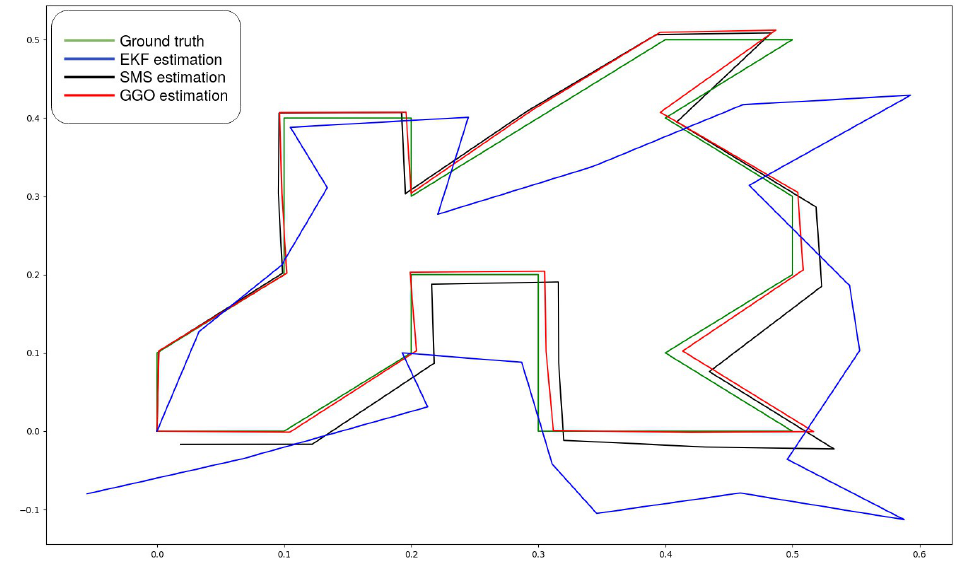
Figure 6. 2D test results. The camera was moved in different steps on the ‘x’ and ‘z’ camera